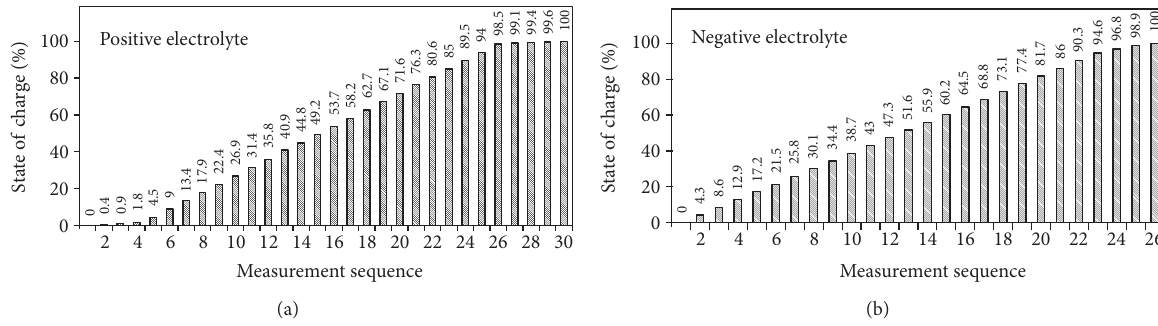
F 2: (a) e state of charge (SOC) of each measurement for the positive electrolyte. (b) e state of charge (SOC) of each measurement for the negative electrolyte.